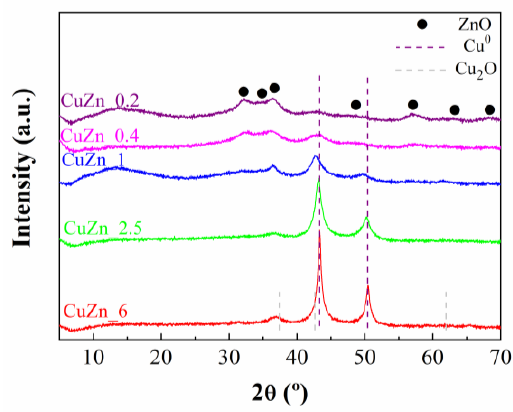
Figure 4. XRD patterns of the CuZn_X catalysts.